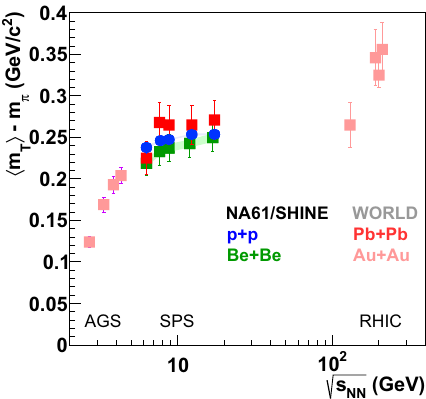
Fig. 18 Energy dependence of the mean transverse mass of π − mea- sured at mid-rapidity in central Be + Be, Pb + Pb [2,3] and Au + Au [32,33] collisions and inelastic p+p interactions